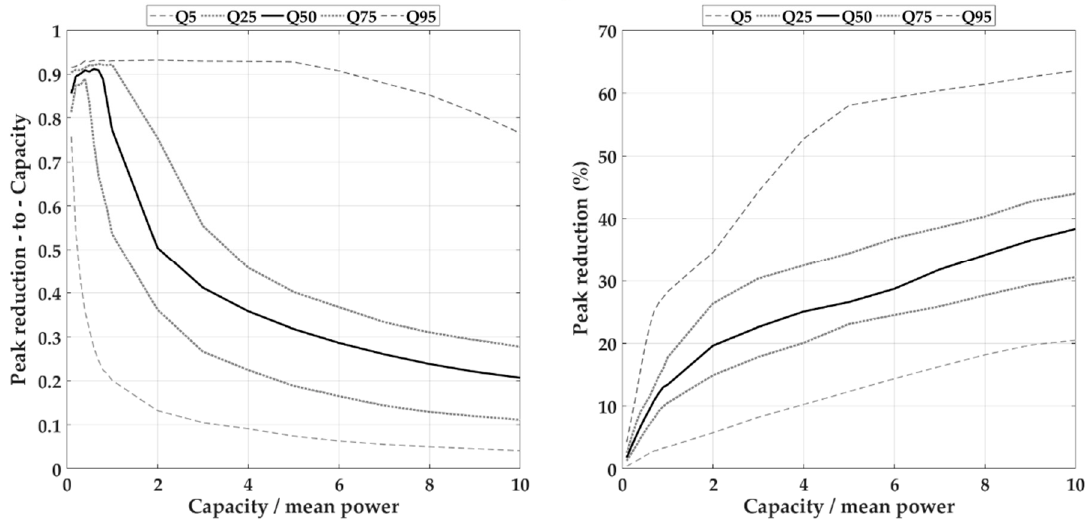
Figure 6. Simulation results: ( a ) Peak reduction-to-capacity (left), ( b ) peak reduction (right).